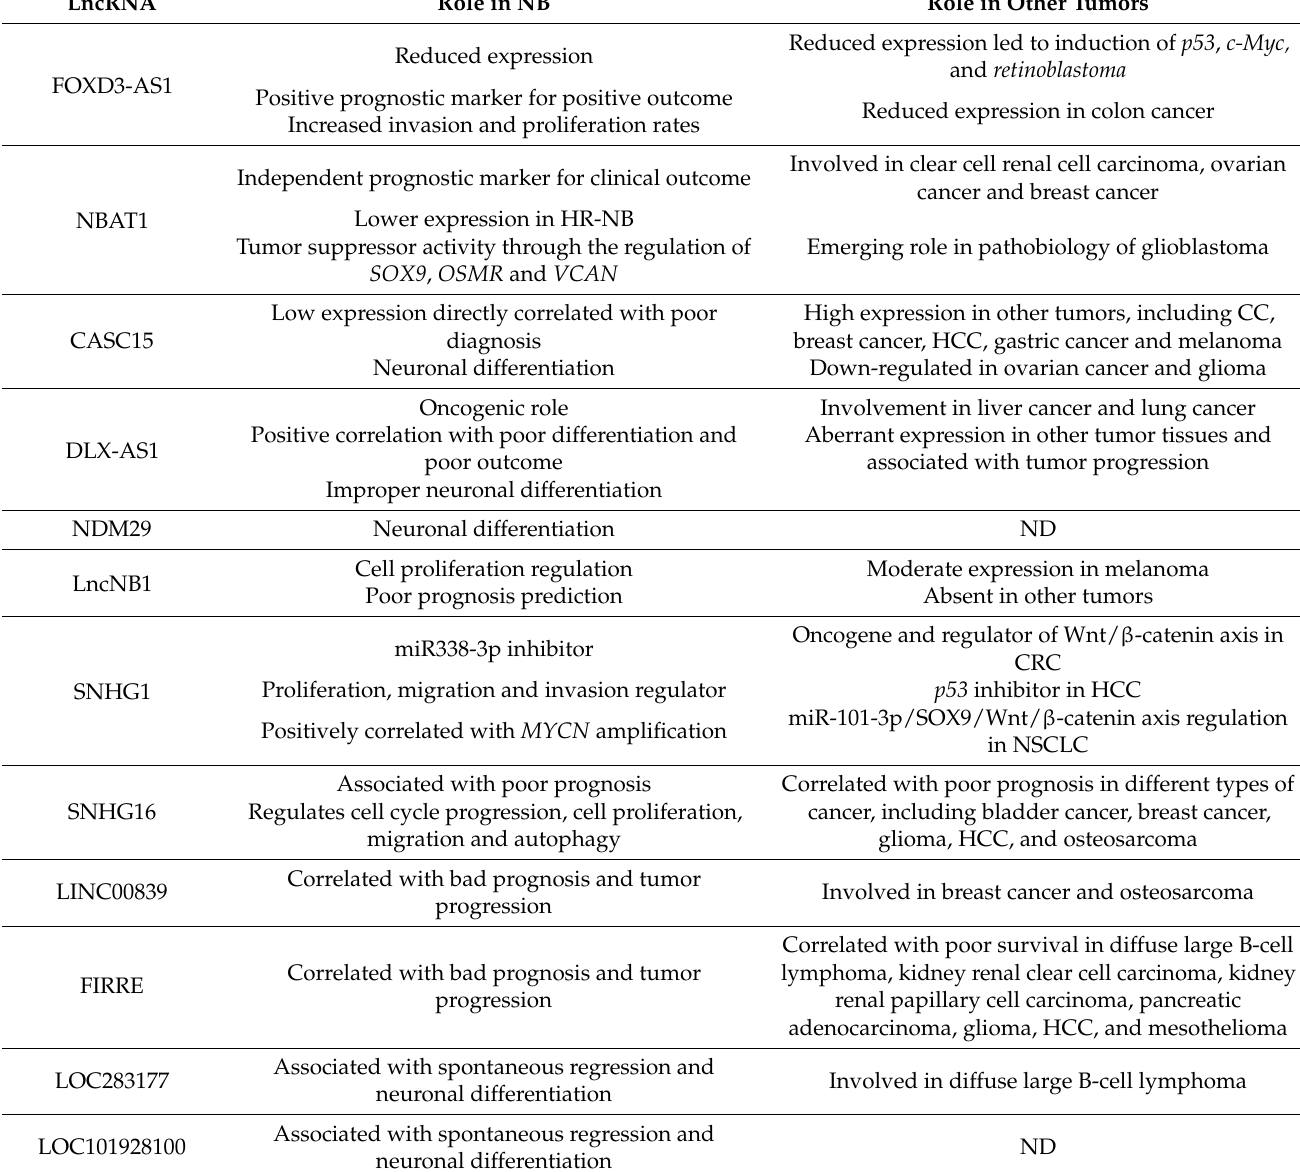
Table 1. Role of lncRNAs in neuroblastoma (NB) and in other